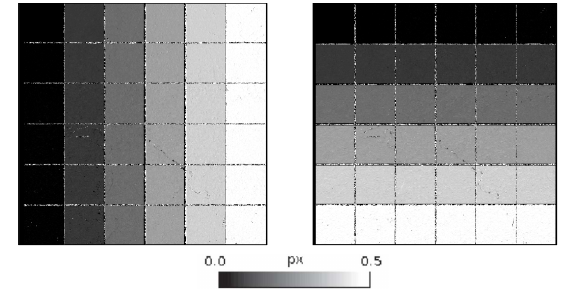
Figure 10: On the left: clinical use of the intra-oral scanner Condor®. On the right: 3D dental impression made by this scanner. Medicis takes part in the estimation of its cameras